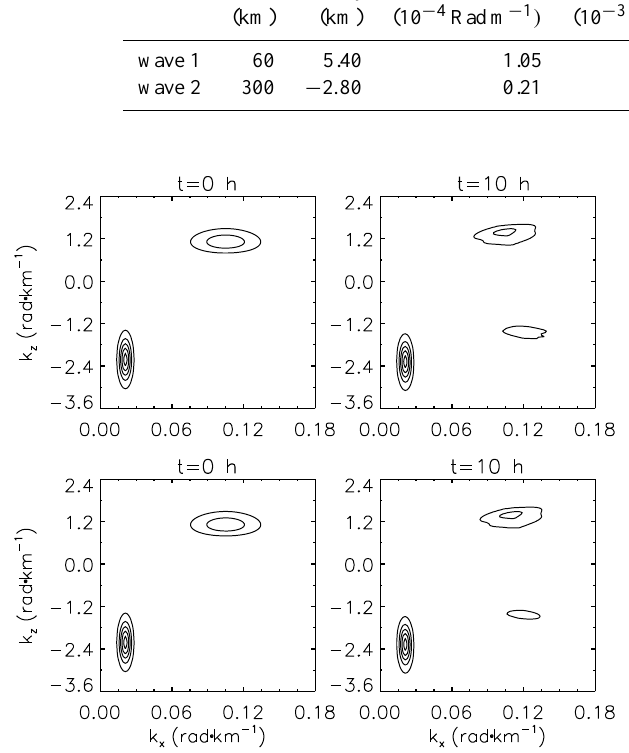
Fig. 9. Normalised wavenumber spectra of interacting waves in cases 3 (top) and 4 (bottom). The values of contours are 0.1, 0.3, 0.5, 0.7 and 0.9.